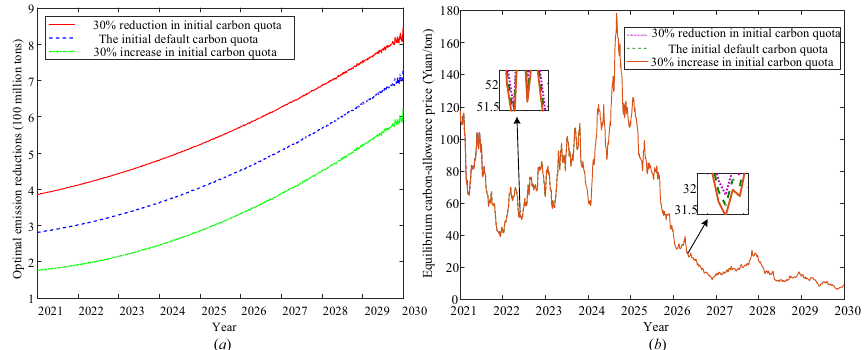
Fig. 11 Optimal carbon-emission reductions and equilibrium prices of carbon allowances for different initial carbon